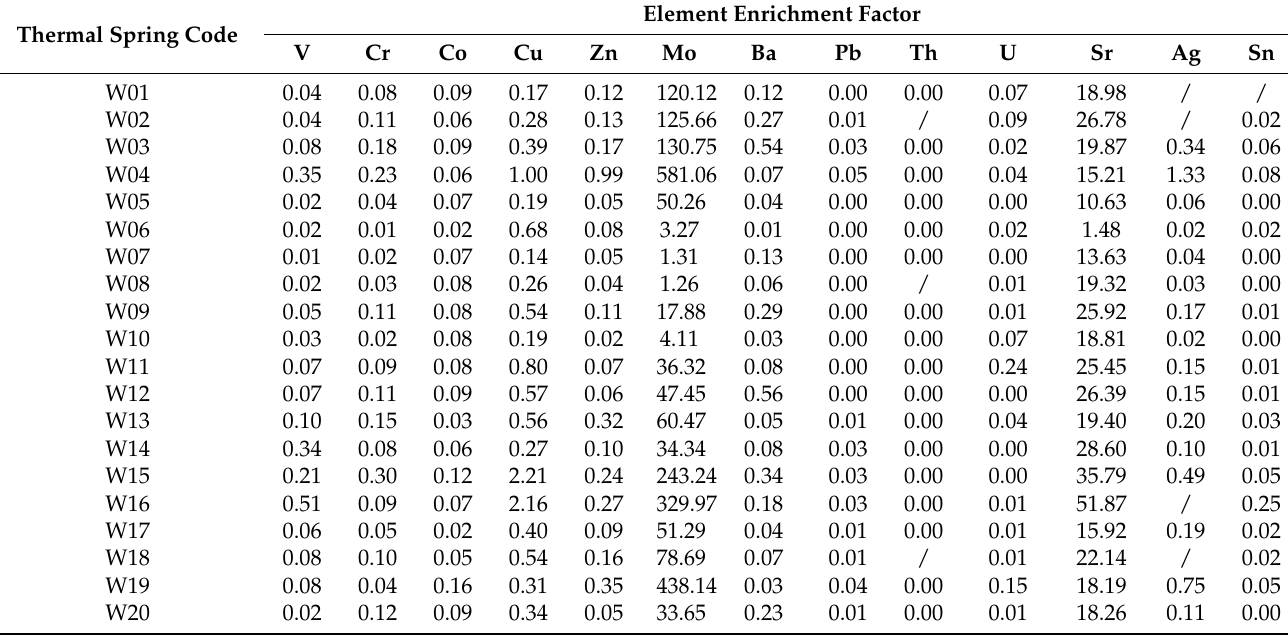
Figure 4. The content of trace elements in the sampled thermal springs. Table 1. The enrichment factor of the trace